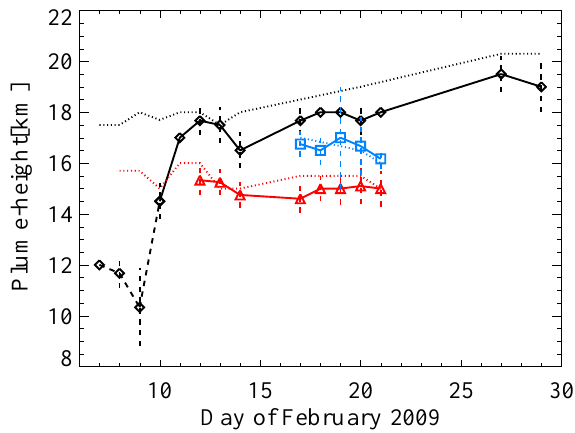
Fig. 12. Lines with symbols: average height of the biomass burn- ing plume caused by the Australian bushfires, derived from MIPAS C 2 H 2 profiles. The black curve represents weaker and low parts of the plume sounded between 7 and 9 February (dashed) and the southern part of the central plume sounded thereafter (solid), which travelled westward after 17 February. The red and blue curves repre- sent the lower parts of the central plume, which were subsequently transported eastward after 14 February. Dotted lines: respective GEM-AQ plume